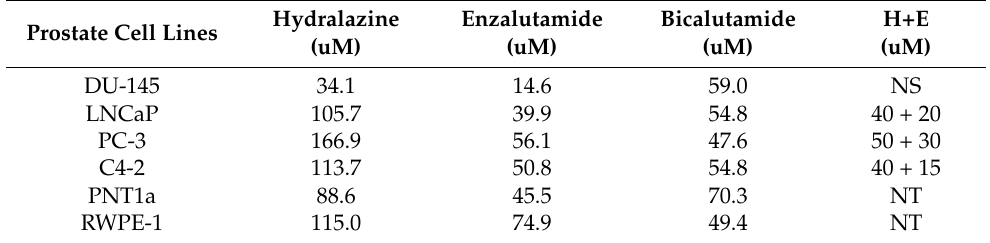
Table 1. EC 50 values and selected drug combinations for functional studies in prostate cell lines. Prostate Cell